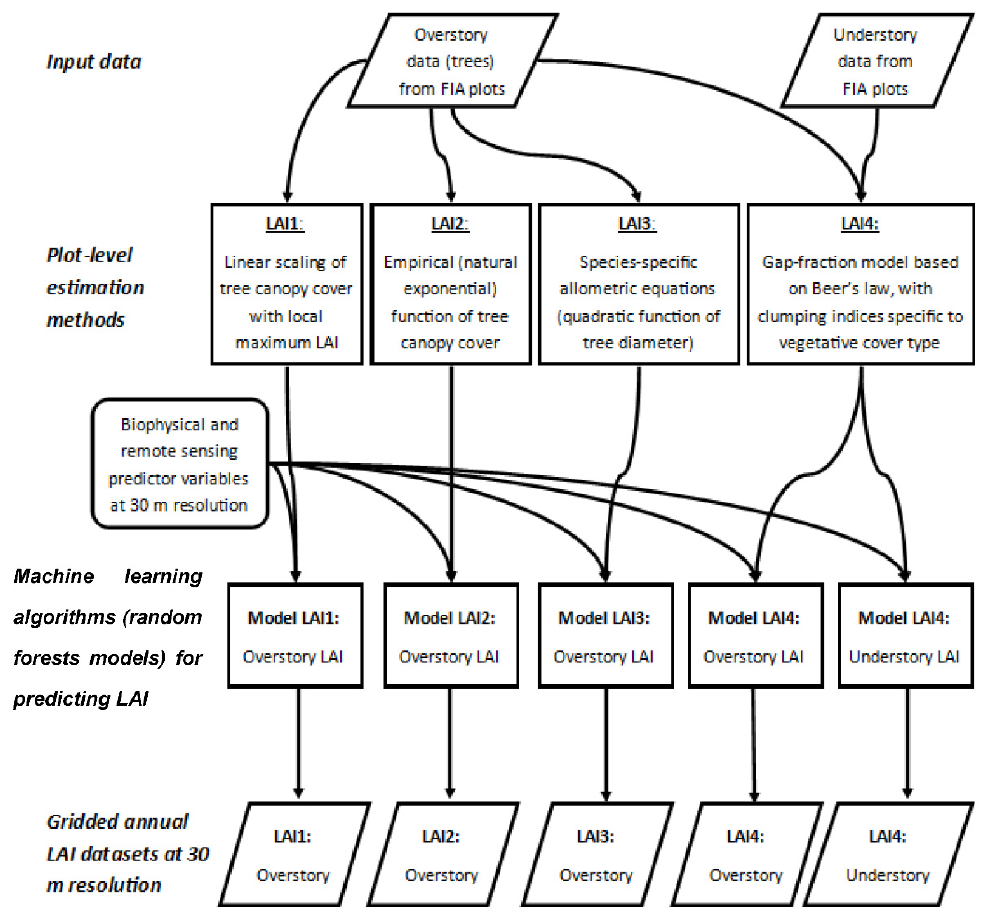
Figure 2. Data sources and methods used to produce plot-level LAI and gridded LAI datasets.